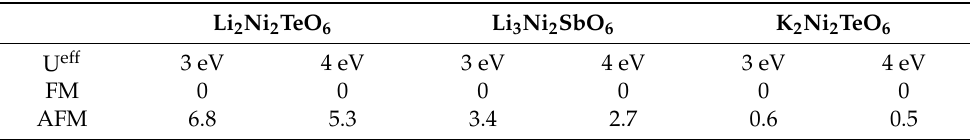
Table 7. Relative energies (in K per formula unit), calculated from DFT + U computations, of the FM and AFM arrangements between the zigzag-ordered layers in A 2 Ni 2 TeO 6 (A = K, Li) and Li 3 Ni 2 SbO 6 .